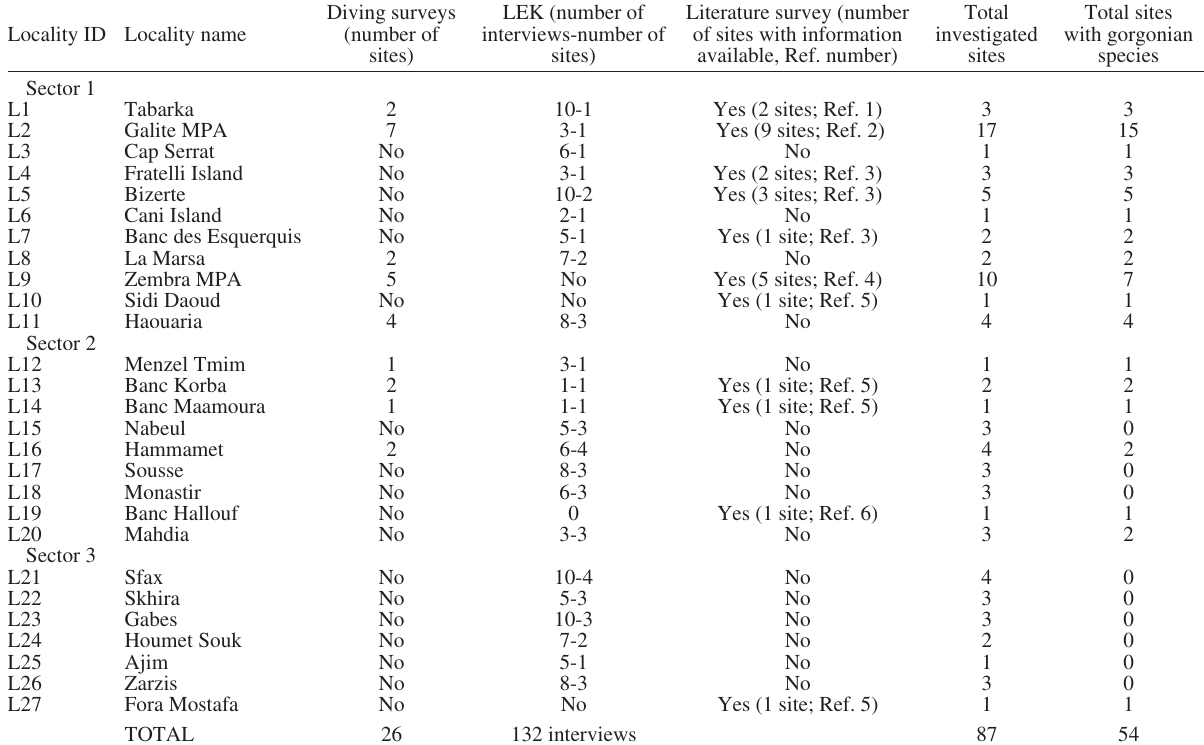
Table 1. – Sampling effort and literature sources investigated in Tunisian waters per sector, locality and sites. Ref. 1, Anomyme 2011; Ref. 2, Andromède 2010a; Ref. 3, Jaziri et al. 2016; Ref. 4, Andromède 2010b; Ref. 5, Ben Mustapha et al. 2004; Ref. 6, Ben Mustapha and Afli 2007. For full references, see the reference